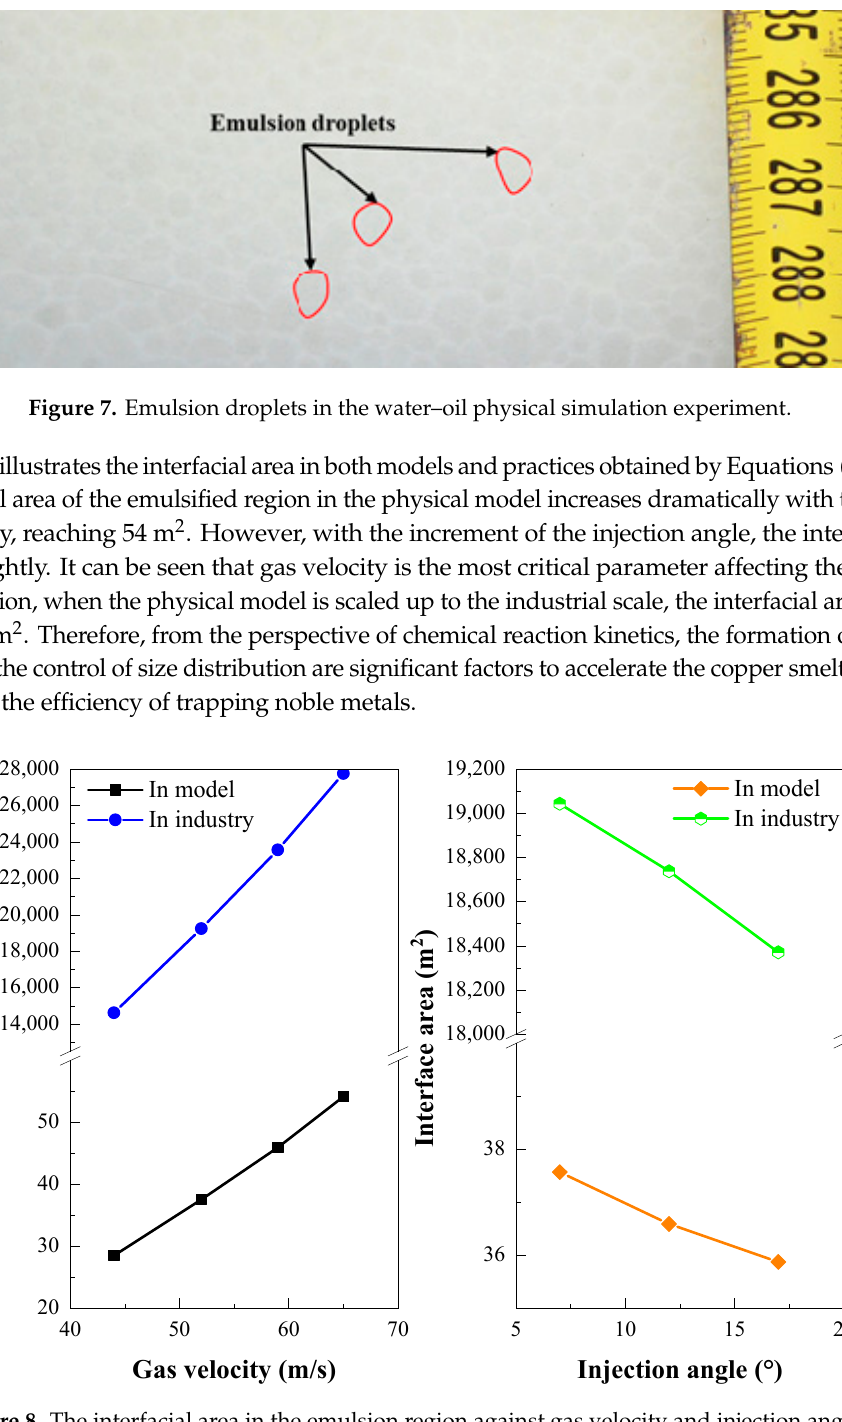
Figure 7. Emulsion droplets in the water–oil physical simulation experiment.